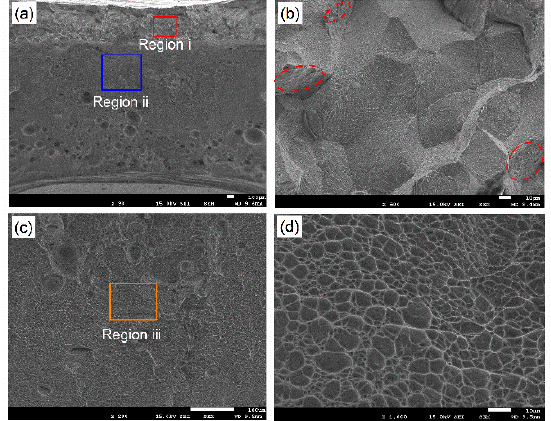
Figure 11. Fracture surface of W1 welded joint after tensile test performed at 923 K: ( a ) macroscopic appearance of fracture; ( b ) high magnification magnification of Region i; ( c ) high magnification magnification of Region ii; ( d ) high magnification magnification of Region iii.